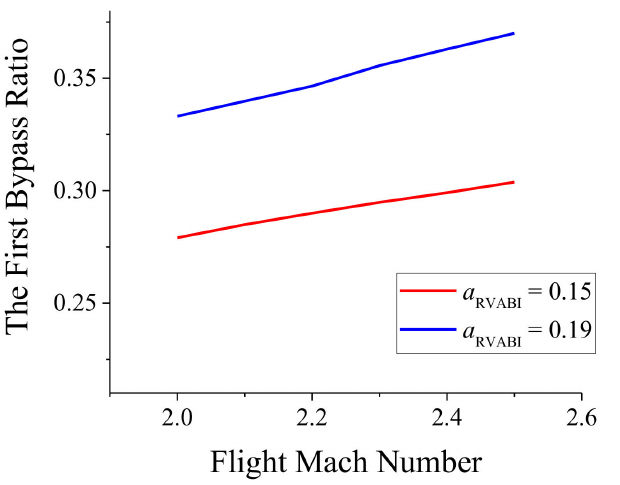
Figure 30. The Variations of The First Bypass Ratio at the conditions of Different Area Coefficients of RVABI ( α RVABI ).